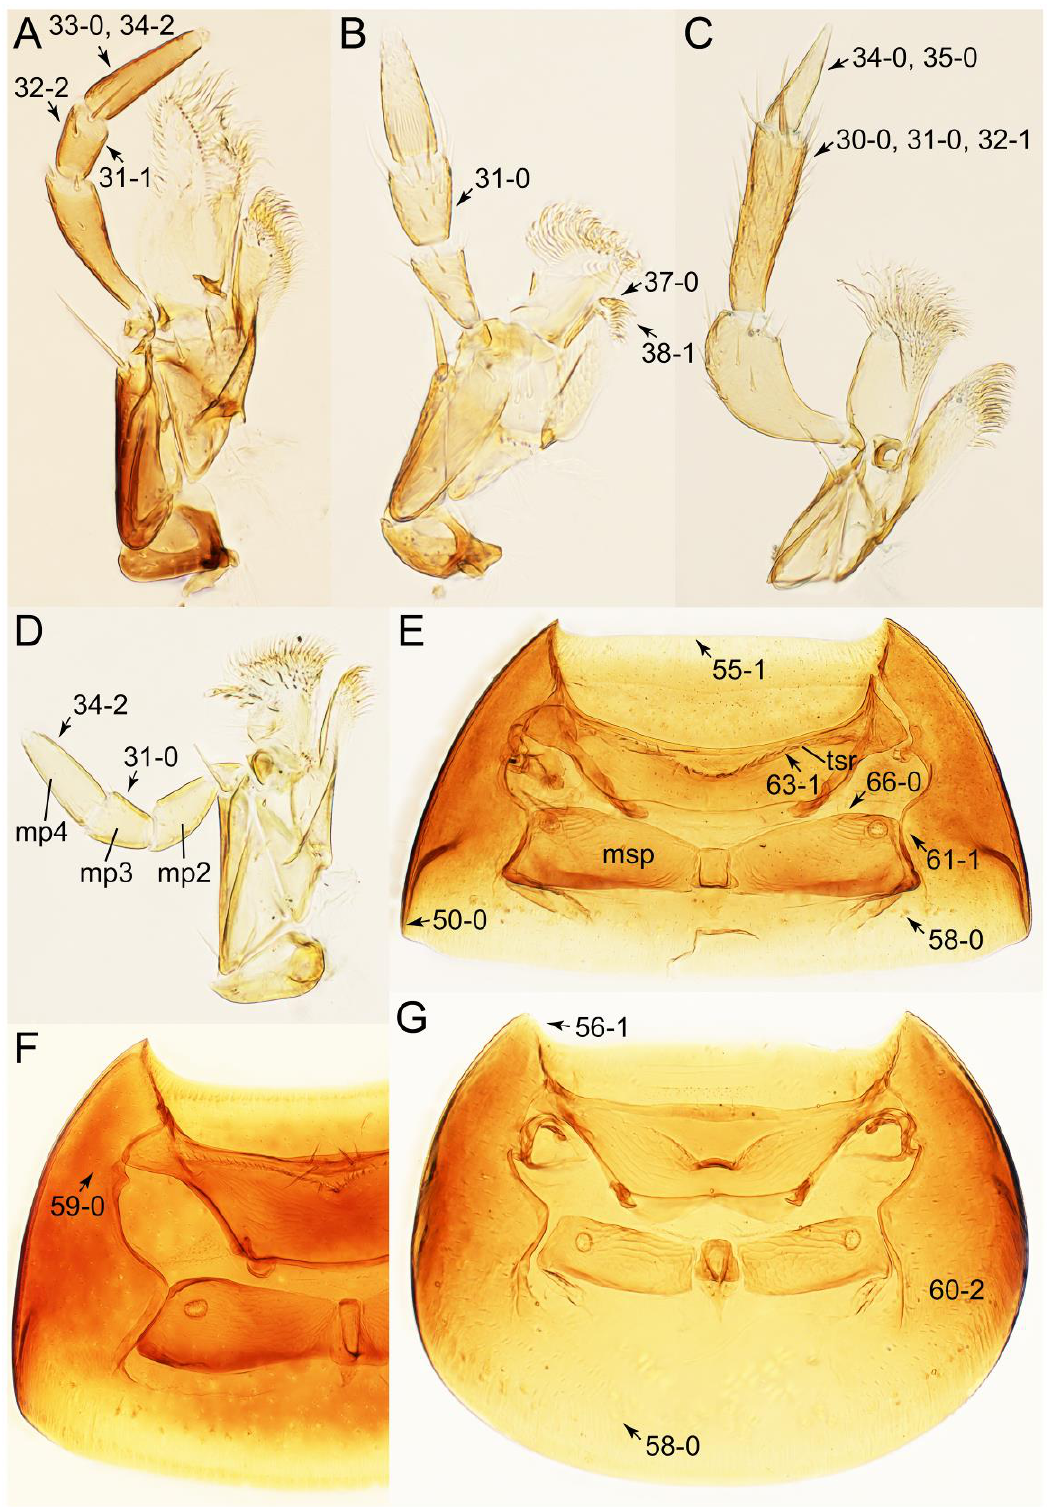
Figure 27. Photographs of body parts of Vatesini, enlarged. ( A ) right maxilla of Cilea limbifera , ventral view. ( B ) left maxilla of Coprotachinus habrocerinus , dorsal view. ( C ) right maxilla of Vatesus praedatorius , ventral view. ( D ) right maxilla of Termitoplus grandis , ventral view. ( E ) prosternum and pronotum of Coproporus colchicus , ventral view. ( F ) prosternum and pronotum of Coproporus laevis , ventral view. ( G ) prosternum and pronotum of Mimocyptus sp., ventral view. Abbreviations: mp2–4, maxillary palpomere 2–4; msp, mesospiracular peritremes; tsr, transverse sternacoxal ridge of prosternum. Characters and character states (format X-X) are indicated on each